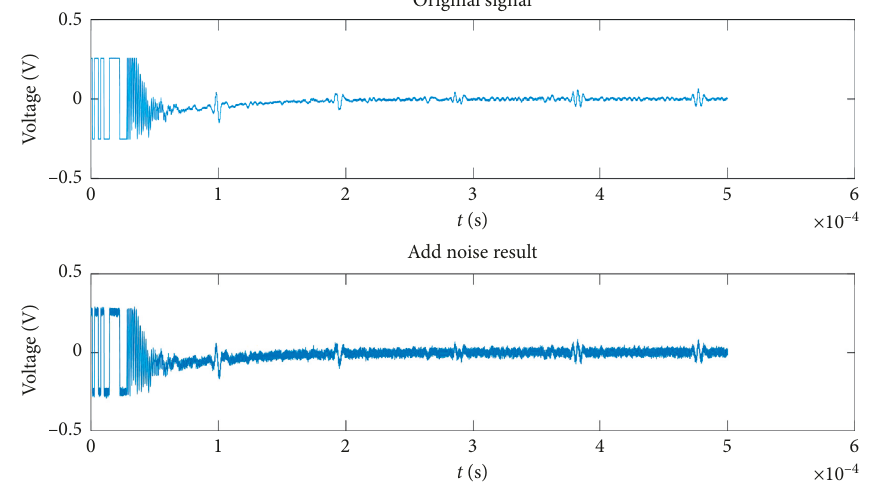
Figure 1: Adding noise to the original